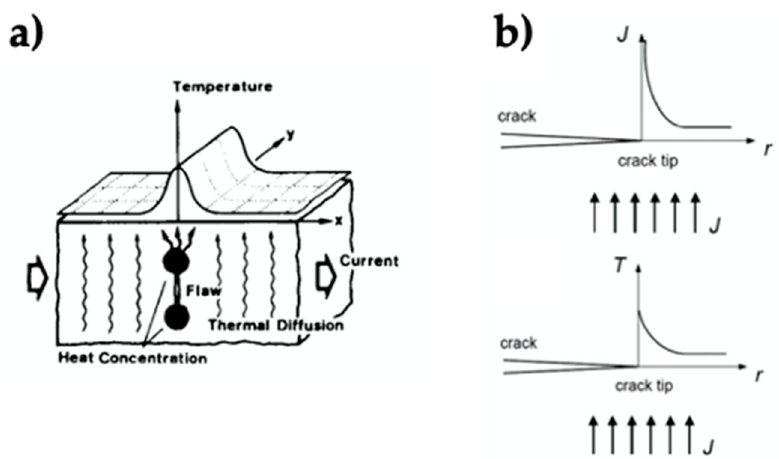
Figure 3. ( a ) Localized temperature rise [48]. Adapted with permission from Sakagami, T; Transactions of the Japan Society of Mechanical Engineers Series A; published by J-Stage, 1992; ( b ) Crack tip fields: electric current density (J) and temperature (T) [49]. Adapted with permission from Liu, T; Engineering Facture Mechanics; published by Elsevier, 2014.